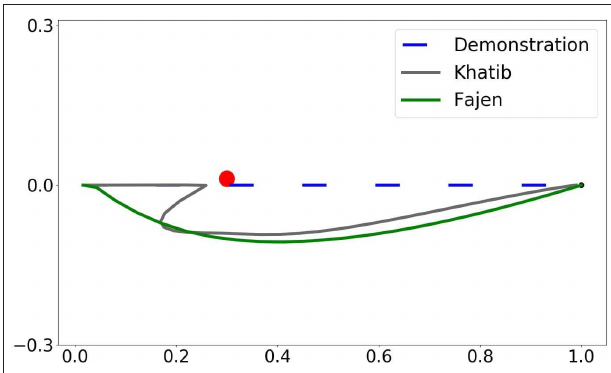
FIGURE 4 | Illustration of the comparison between Khatib and Fajen potential field with Procrustes distance.